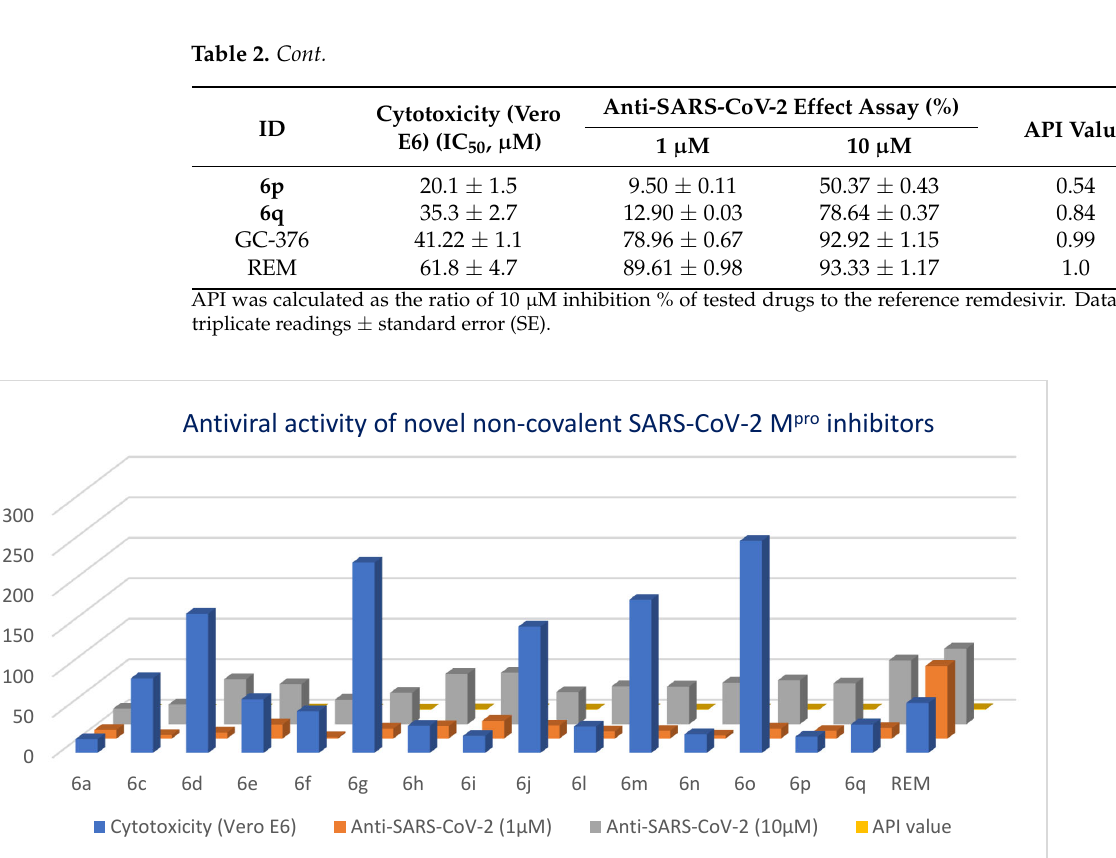
Figure 6. Pyramid-based chart showing the distribution of antiviral activity of target relative to the reference drug.